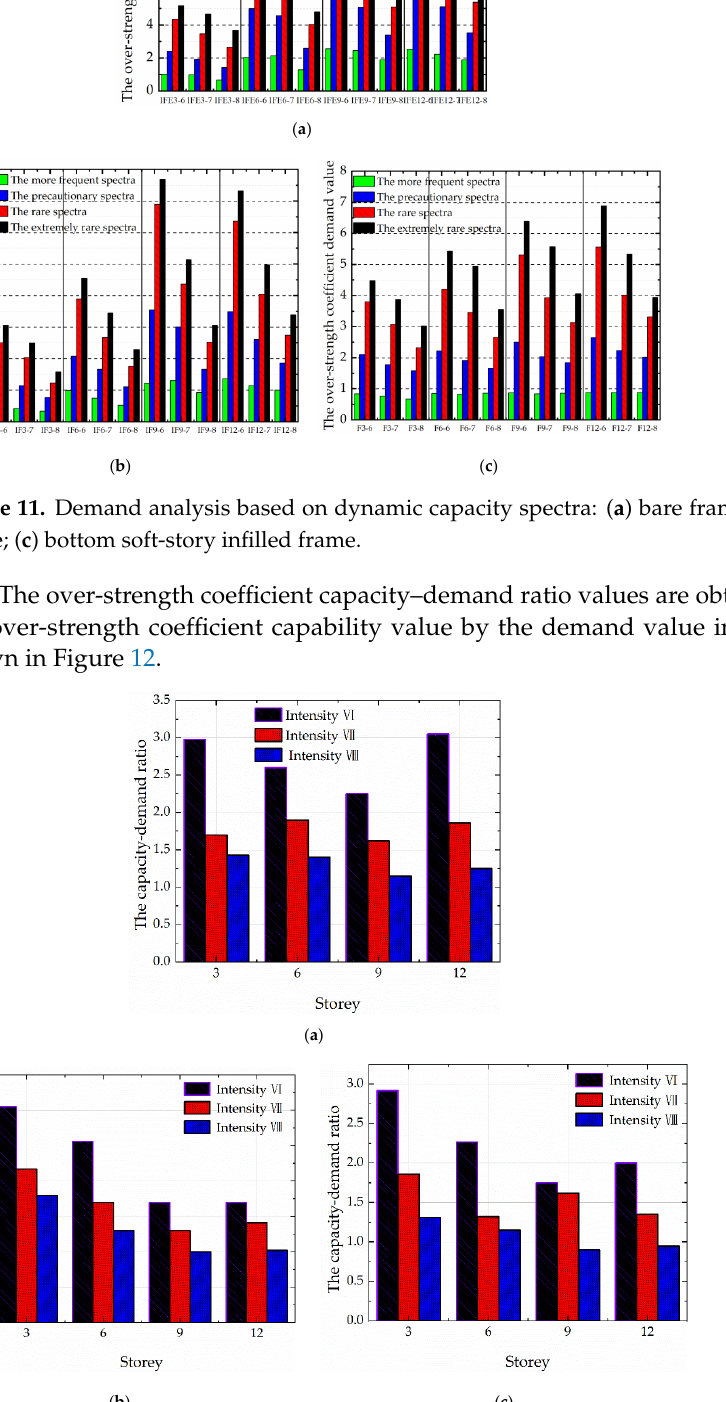
Figure 12. The structural capacity – demand ratio of over-strength coefficient: ( a ) rare frame; ( b ) fully infilled frame; ( c ) bottom soft-story infilled frame.